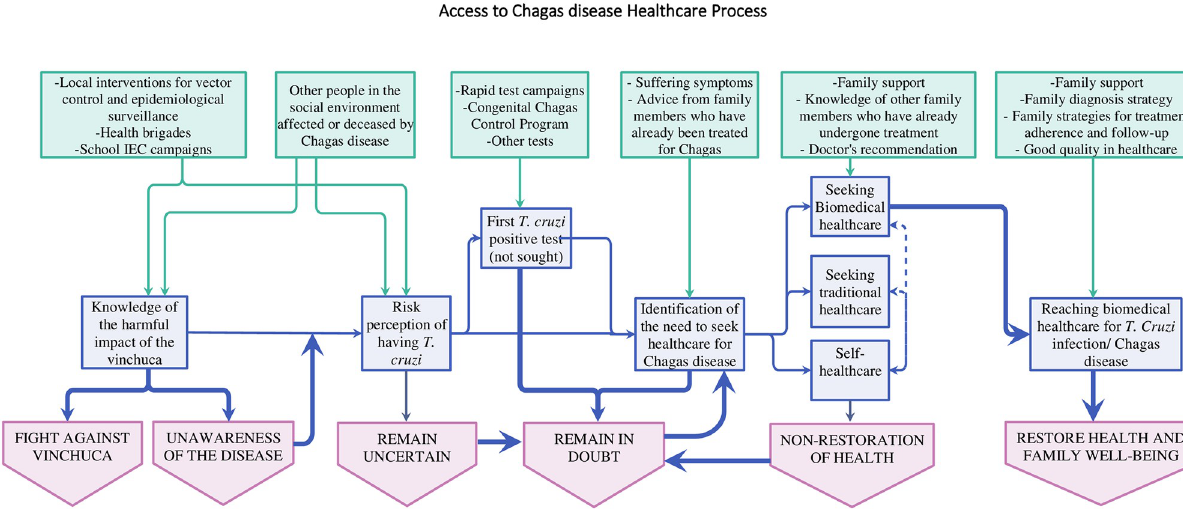
Fig 4. Decision-making in the access to health care for Chagas disease. In green, the most important facilitators that influence the entire process of decision-making in seeking and reaching health care for Chagas disease. In blue and purple, the steps of the common route in the decision-making.